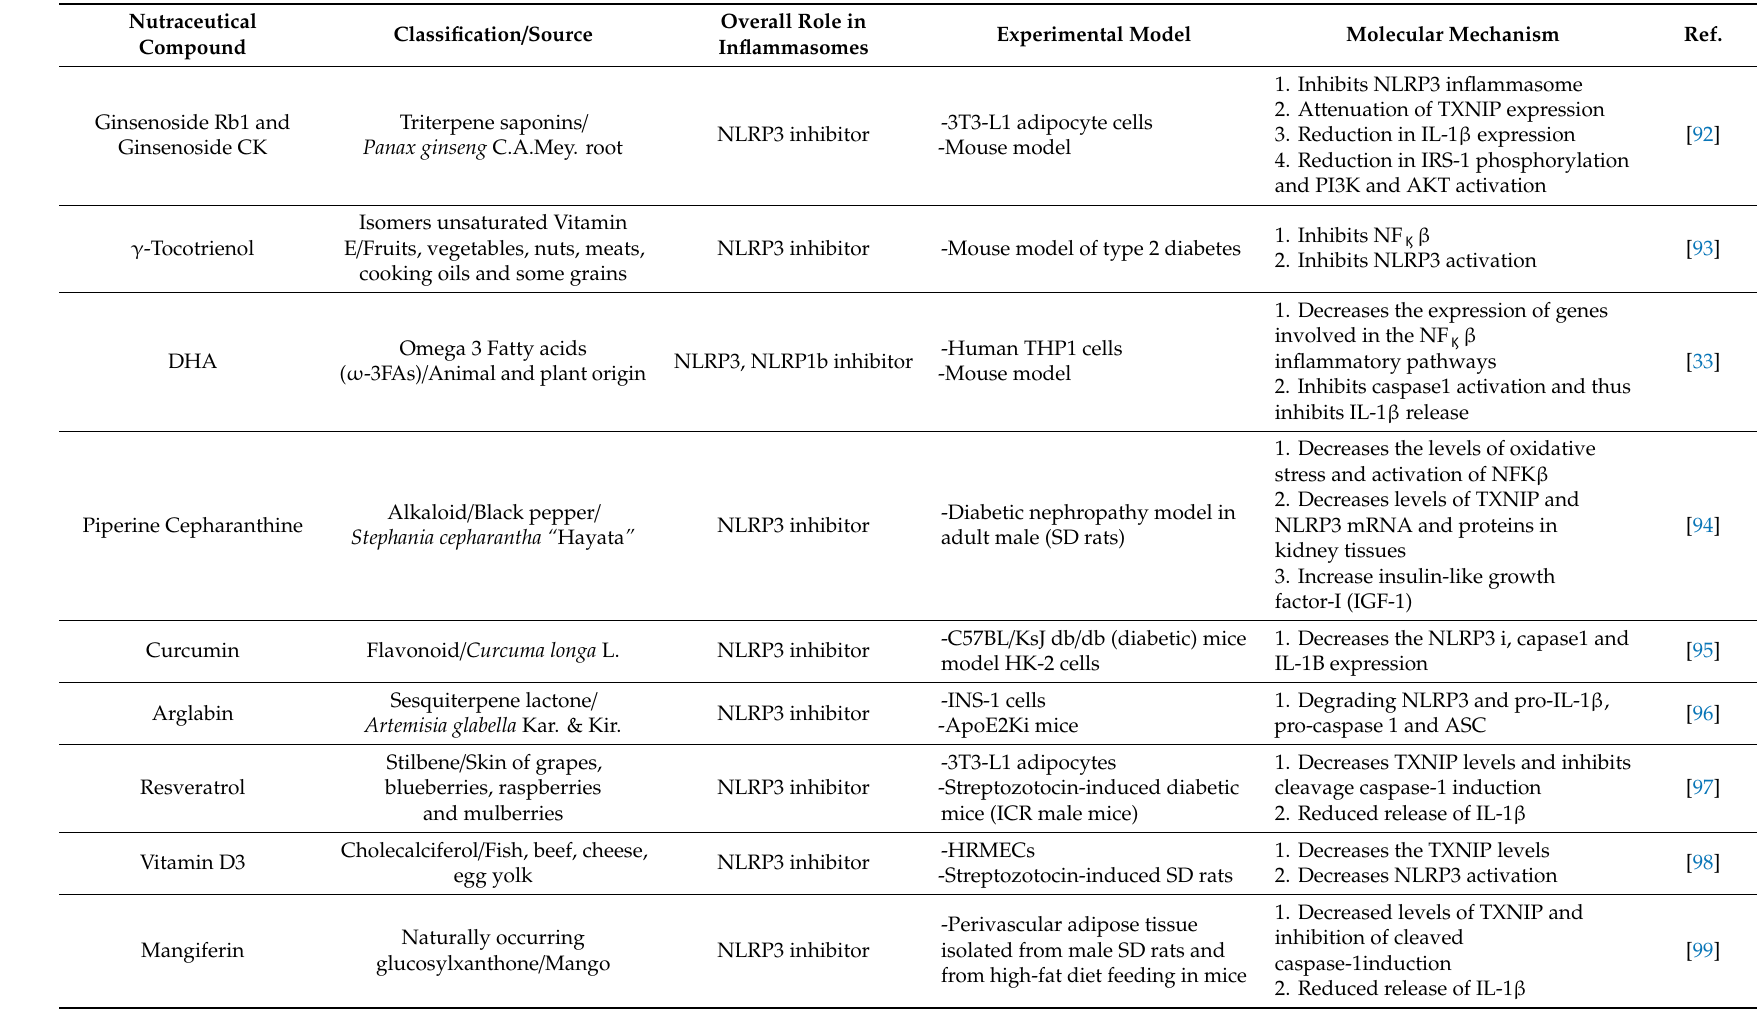
Table 2. List of Nutraceutical Compounds targeting Inflammasomes in Type 2